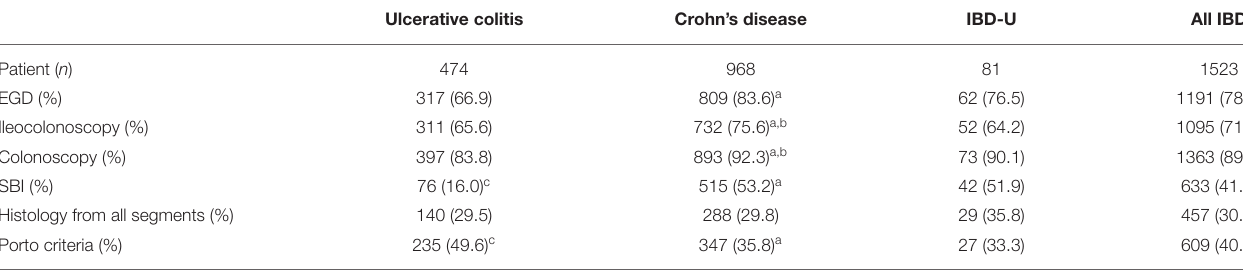
TABLE 1 | Diagnostic workup of newly diagnosed IBD patients of HUPIR registered between 2007 and 2016. Ulcerative